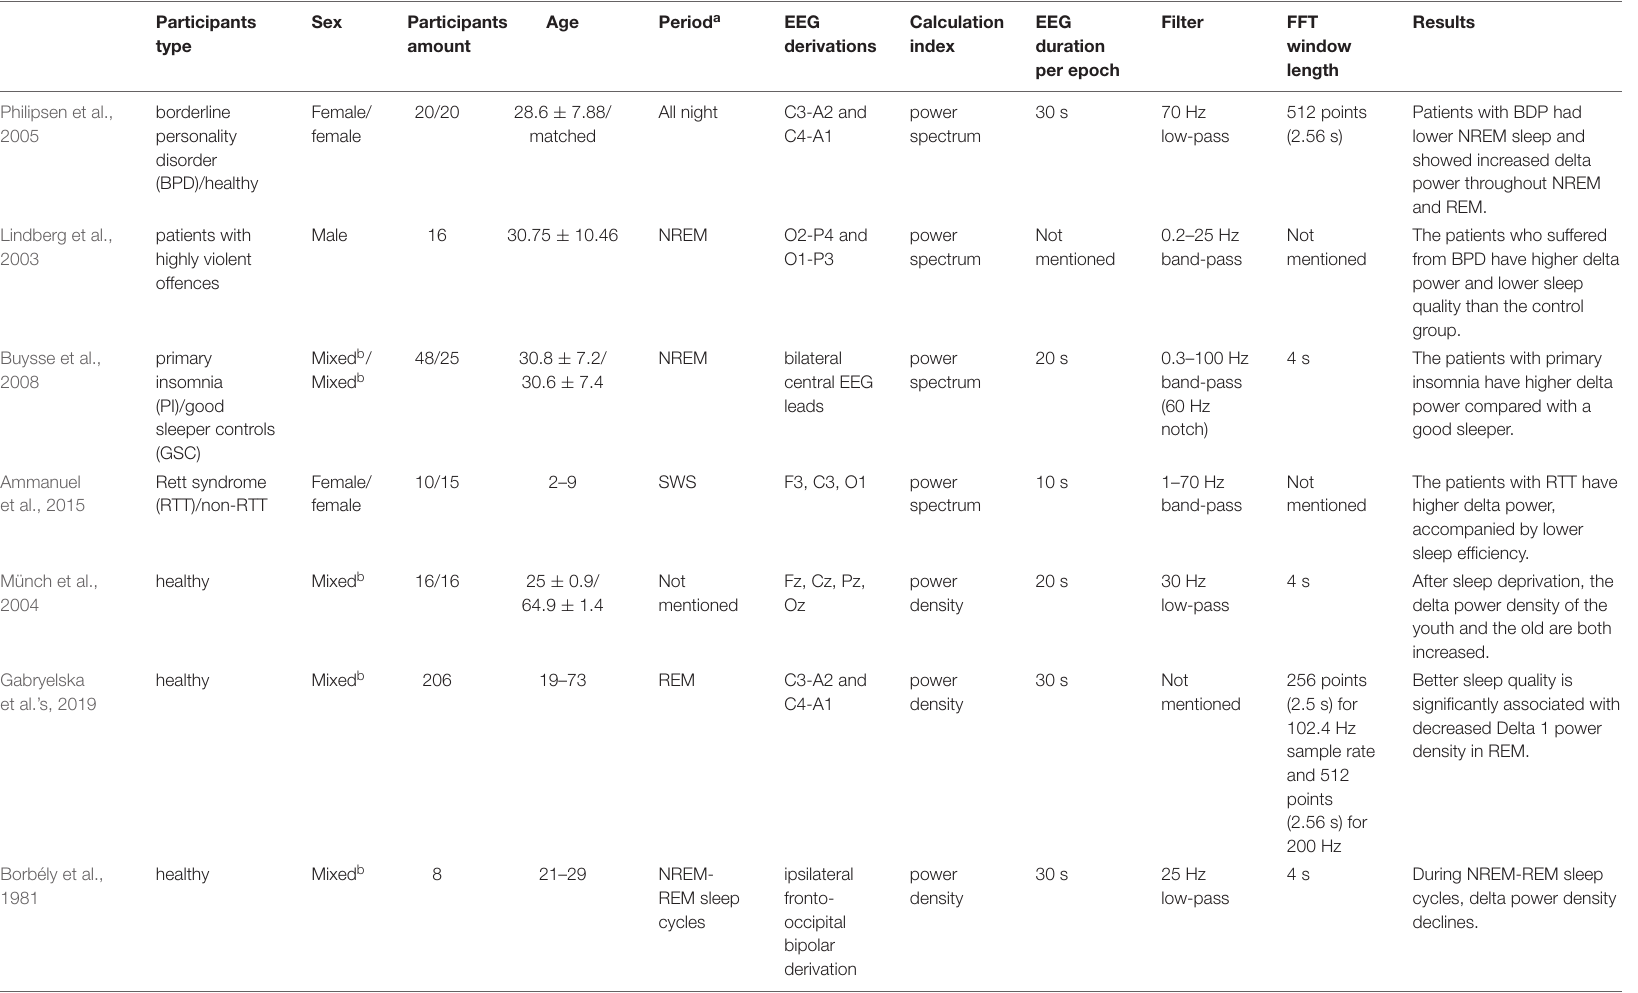
TABLE 1 | A delta power decrease indicates better sleep in different